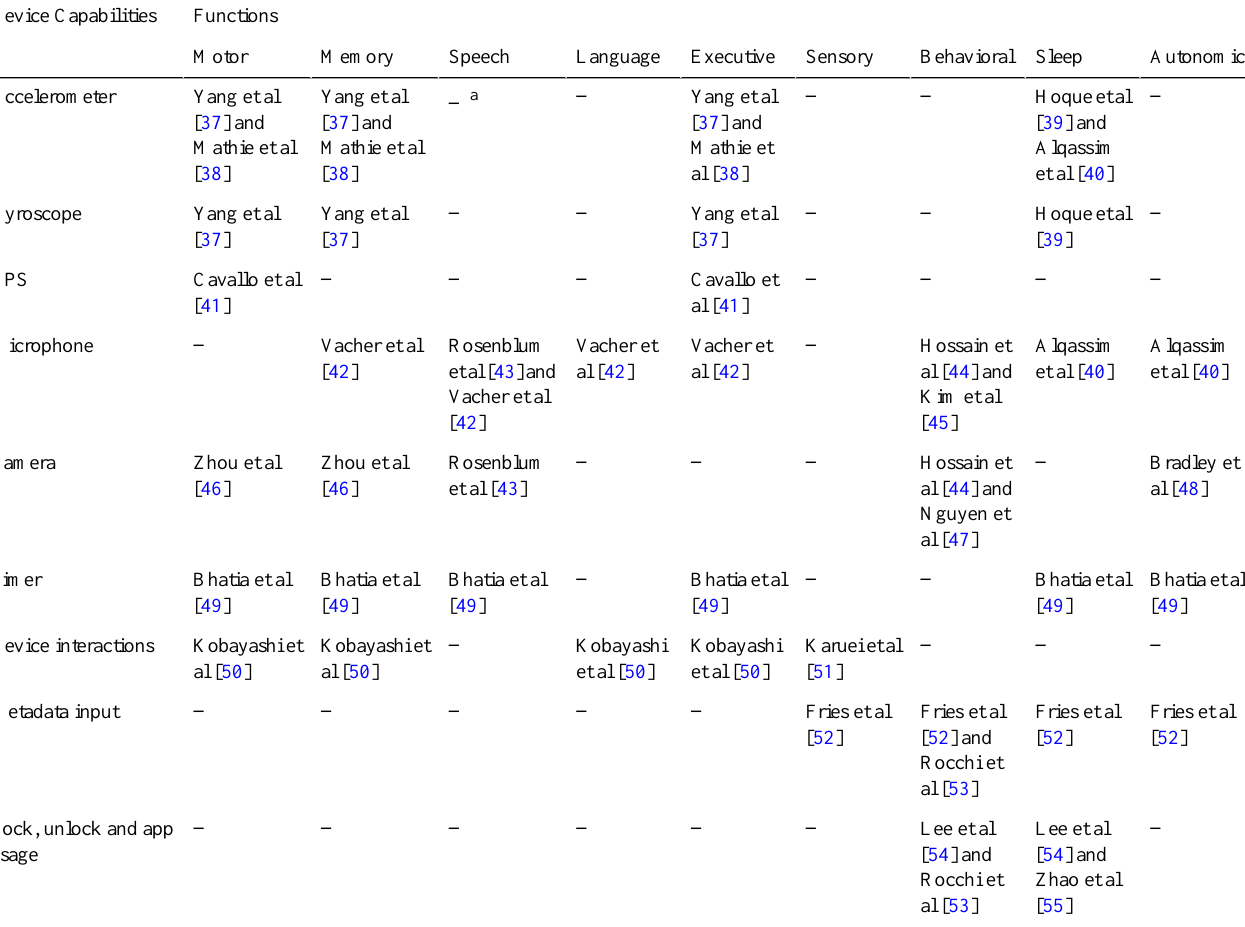
Table 4. References to previous publications regarding mobile device sensors and/or capabilities to monitor neurocognitive functions of interest. FunctionsDevice